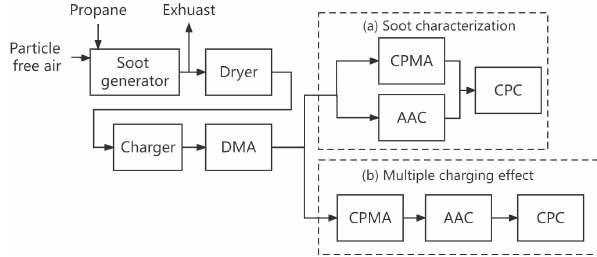
Figure 1. Schematic of the experimental setup: (a) soot characteri- zation and (b) evaluation of multiple charging